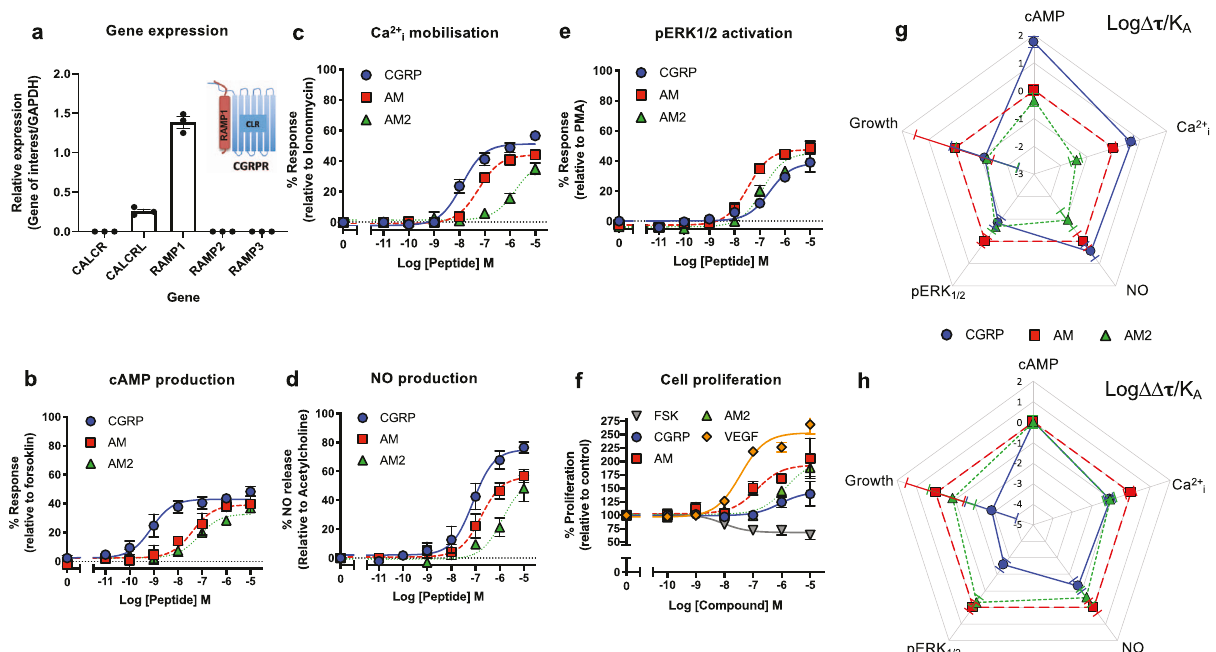
Fig. 3 Switching RAMP expression in HUVECs produces unique signalling bias patterns for CGRP family of agonists. a Expression of CALCR, CALCRL , RAMP1 , RAMP2 , and RAMP3 genes in RAMP1 expressing HUVECs. Data normalised to GAPDH expression. n = 3 independent experiments. b – f Dose – response curves were constructed for RAMP1 expressing HUVECs stimulated with CGRP, AM or AM2 and the cAMP levels quanti fi ed relative to forskolin (100 μ M) ( n = 4) ( b ), mobilisation of Ca 2 + i relative to ionomycin (10 μ M) ( n = 6) ( c ), total NO production relative to acetylcholine (10 μ M) ( n = 3) ( d ), intracellular ERK 1/2 phosphorylation relative to PMA (10 μ M) ( n = 3) ( e ), and extent of cell proliferation (after 72h) relative to vector treated control and VEGF ( n = 4) ( f ). Data are analysed using a three-parameter non-linear regression curve or the operational model of receptor agonism 27 . g – h Signalling bias plots were calculated as Δ Log( τ /K A ) ( g ) or ΔΔ Log( τ /K A ) ( h ) for each agonist and for each signalling pathway. Determination of values requires normalisation to a reference agonist (AM) alone in ( g ), while for ( h ) values were normalised to both a reference agonist (AM) and a reference pathway (cAMP). All data represent mean±SEM for n